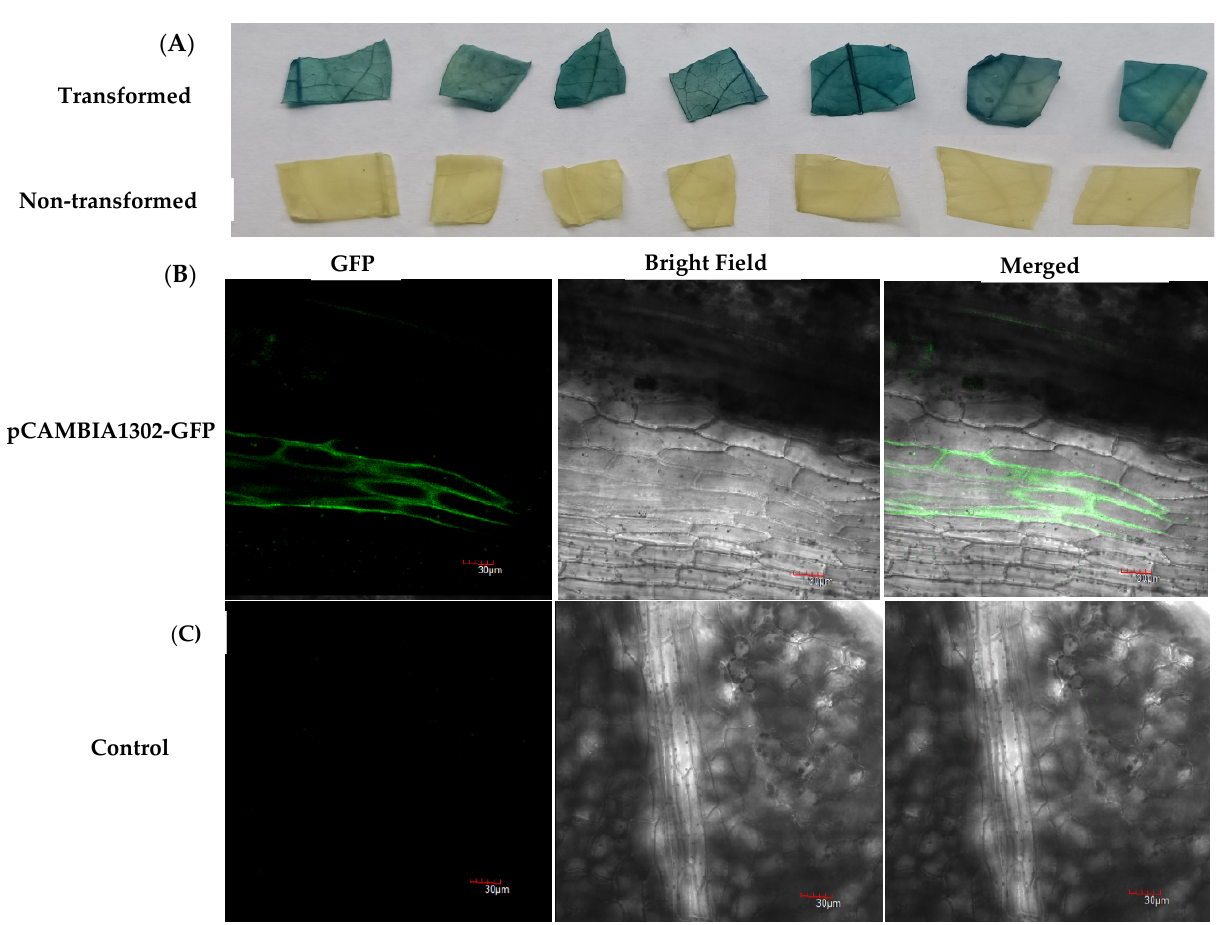
Figure 3. Histochemical GUS staining and visualization of GFP fluorescence in transgenic plants. ( A ) Histochemical β-glucuronidase (GUS) staining of leaf segments of different transgenic plants and non-transgenic control plants. ( B , C ) Visualization of GFP reporter gene in transgenic (pCAMBIA1302) and non-transgenic (control) passion fruit plant leaves under laser scanning confocal microscope. ( B ) GFP expression on transformed passion fruit plant leaf; ( C ) non-transformed plant leaf as control; all bars are 30 µm.